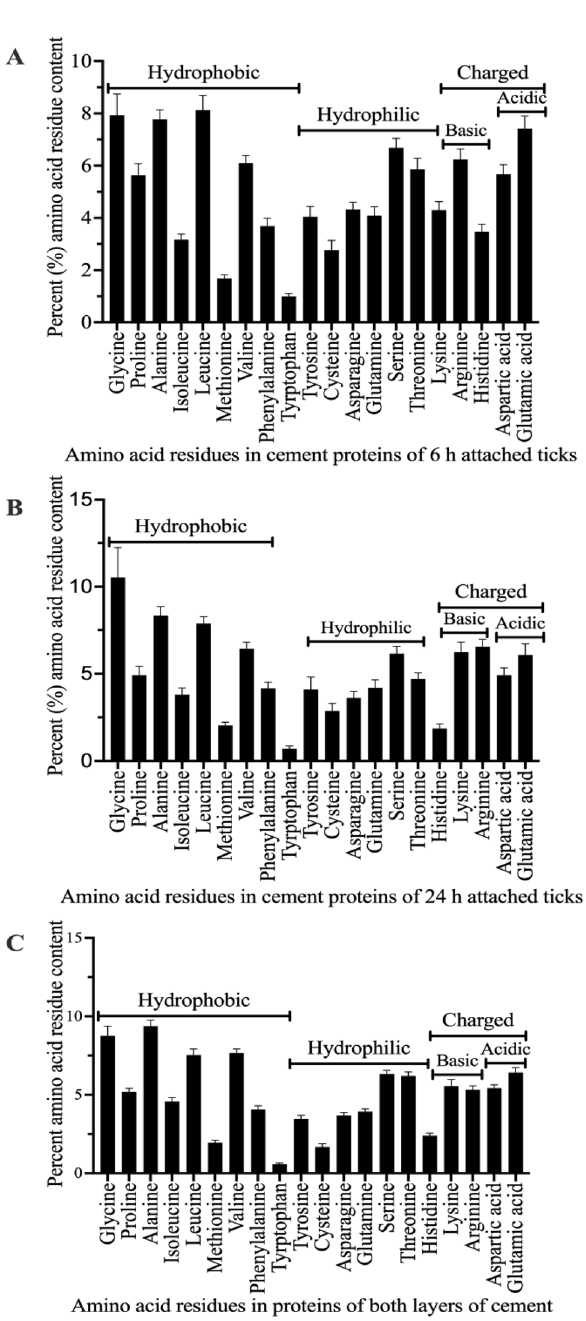
Figure 5. I. scapularis tick cement proteins have high content of hydrophobic amino acid residues. Counts of amino acid residues were enumerated on bioinformatics.org server (https:// www. bioin forma tics. org). Amino acid residue counts were plotted in PRISM 9. Classification of amino acid residues as hydrophobic and hydrophilic reflect likelihood to interact with water while charged (basic and acidic) being charged at neutral pH as defined in 10